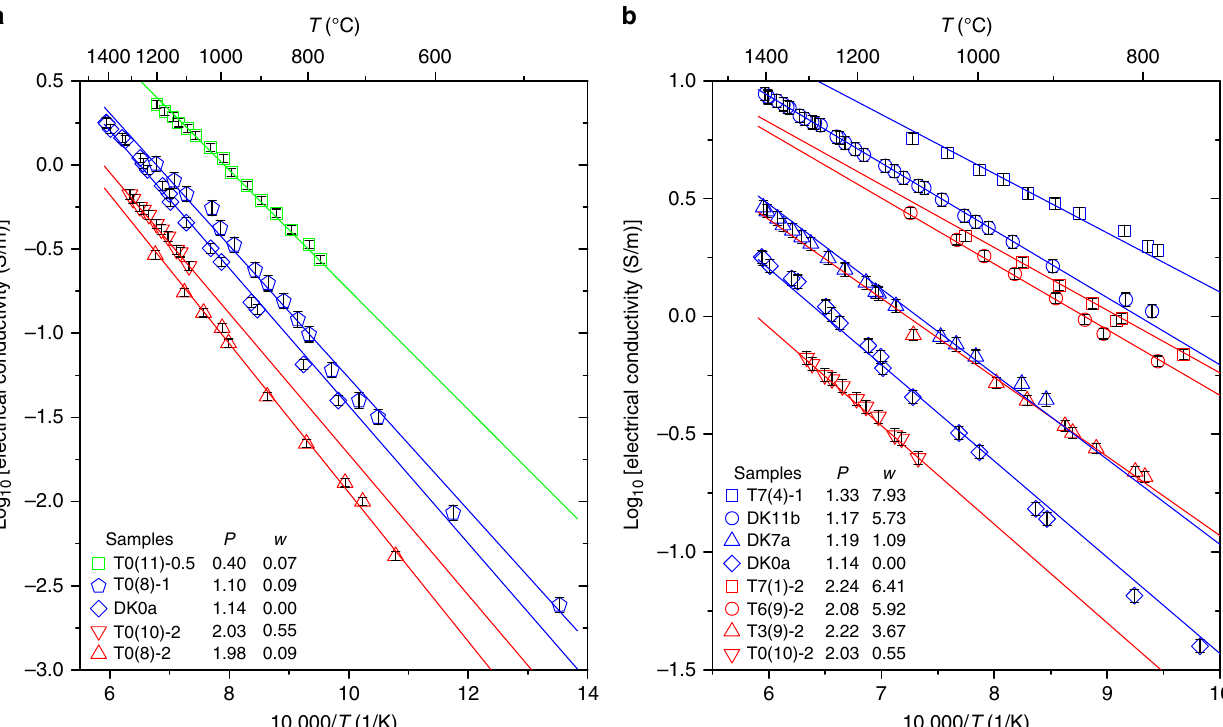
Fig. 3 Electrical conductivity measurements on dry and hydrous melts plotted in Arrhenius diagrams. The straight lines indicate the fi ts of the P – T – H 2 O model (Eqs. (1) – (4)). P is the pressure (GPa), w is the water concentration (wt%). a Experimental results for nominally dry samples at different pressures. b Experimental results for different water concentrations at ~1 GPa or ~2